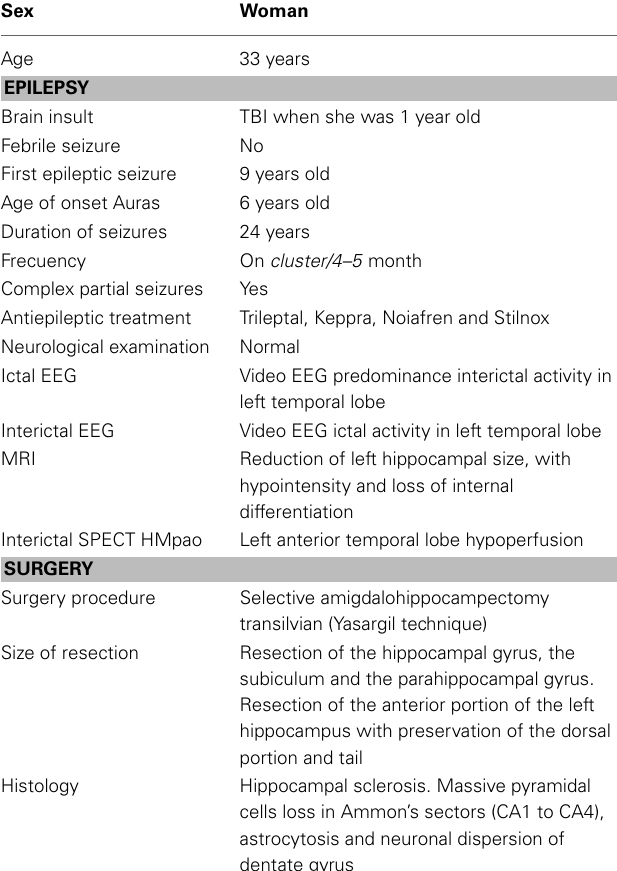
Table 1 | General epilepsy history and summary of